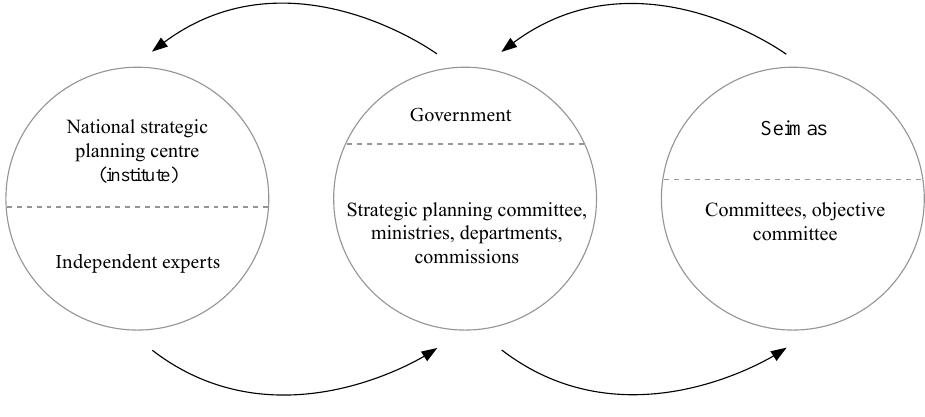
Fig. 1. Organisational model for strategic economic development